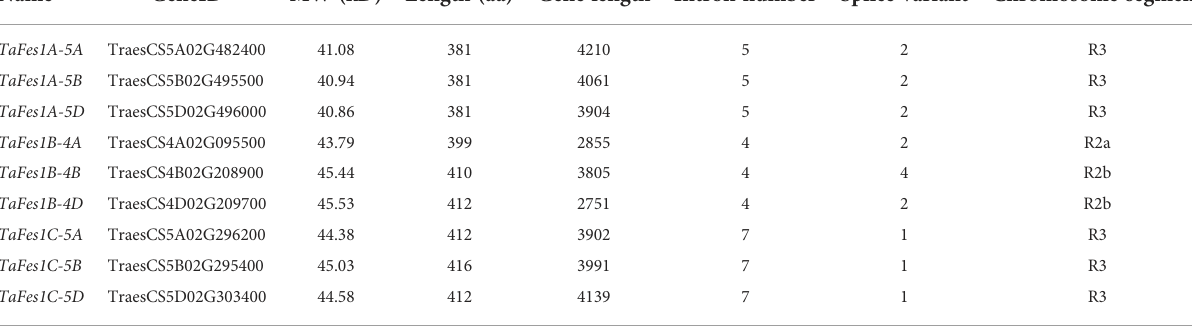
TABLE 1 Information of TaFes1s